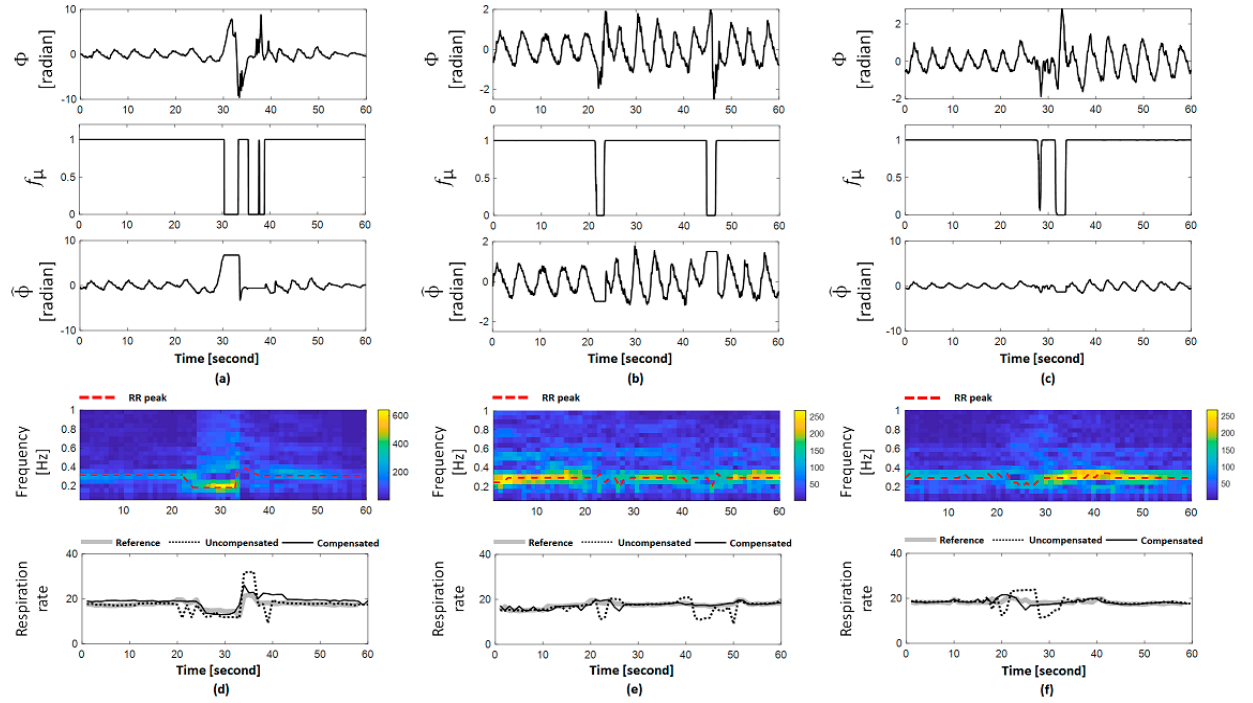
Figure 10. Compensated respiration rate estimation and comparison for each situation in which the driver ’ s movement is present. ( a , d ) Respiration compensation in sudden stop, ( b , e ) respiration compensation in stop and start, ( c , f ) respiration compensation in lane change .